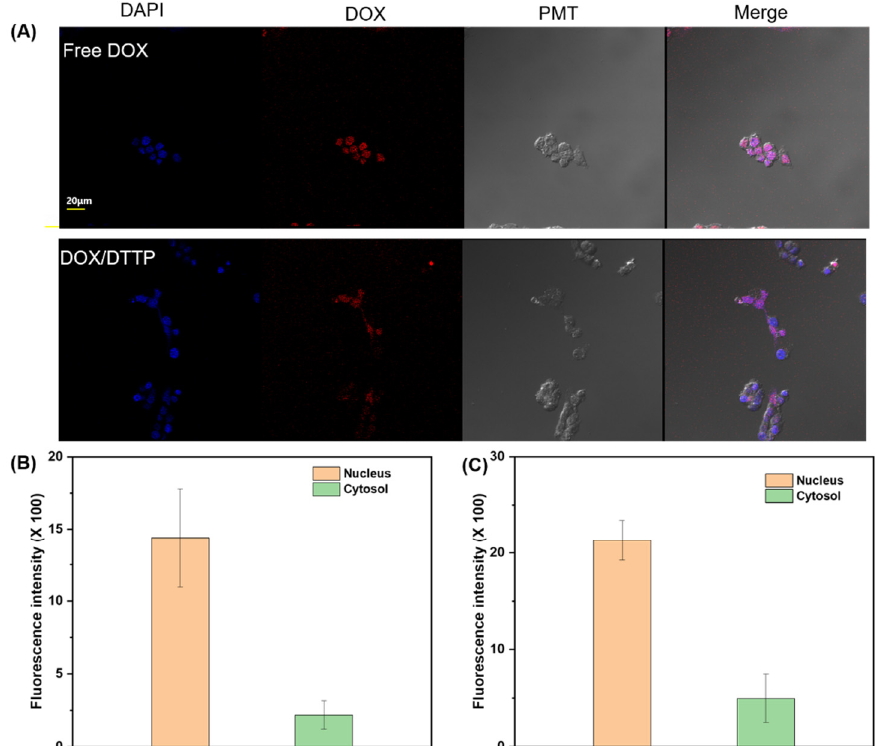
Figure 7. CLSM images of MCF-7 cells incubated with free DOX and DOX-loaded DTTP micelles for 24 h. Left to right: DAPI staining; intracellular DOX fluorescence; photomultiplier (PMT) images; and overlays of two images ( A ). Fluorescence intensity in nucleus and cytosol after treatment with free DOX ( B ). Fluorescence intensity in nucleus and cytosol after treatment with DOX-loaded micelles ( C ).